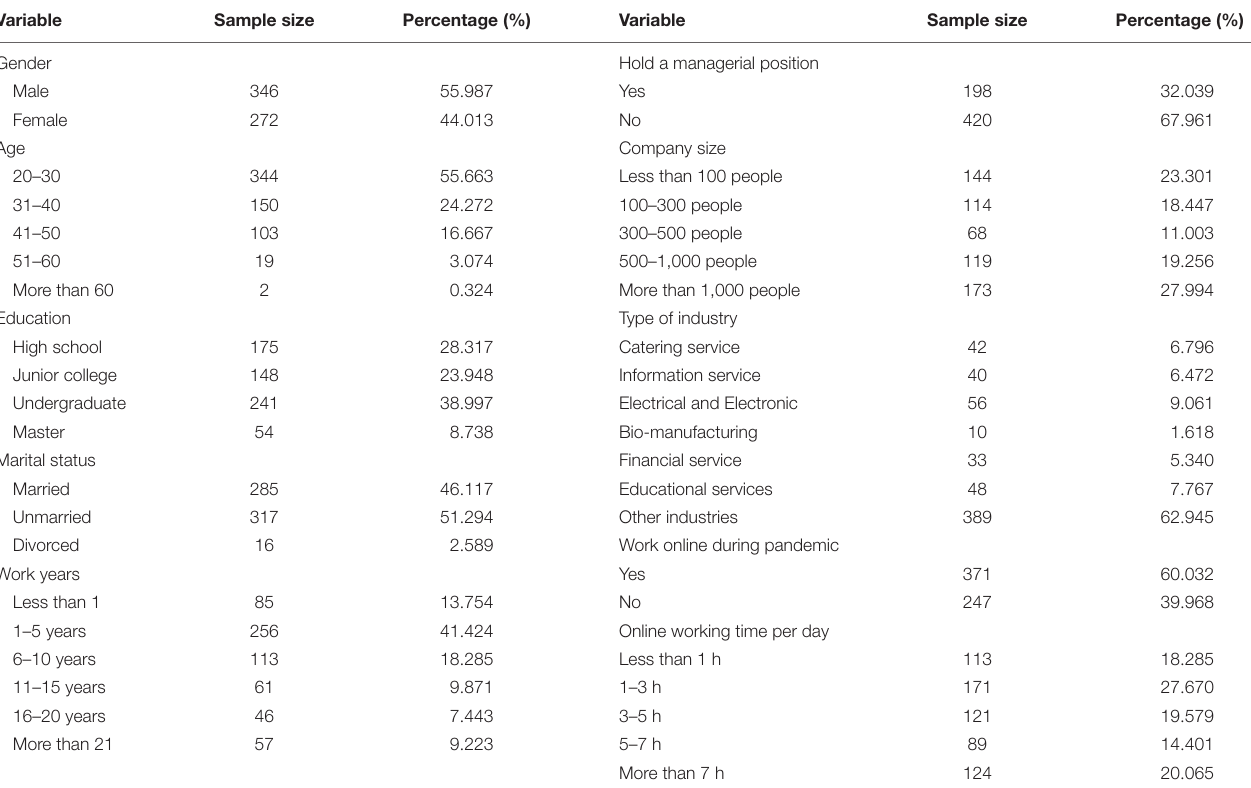
TABLE 1 | Demographic characteristics of research